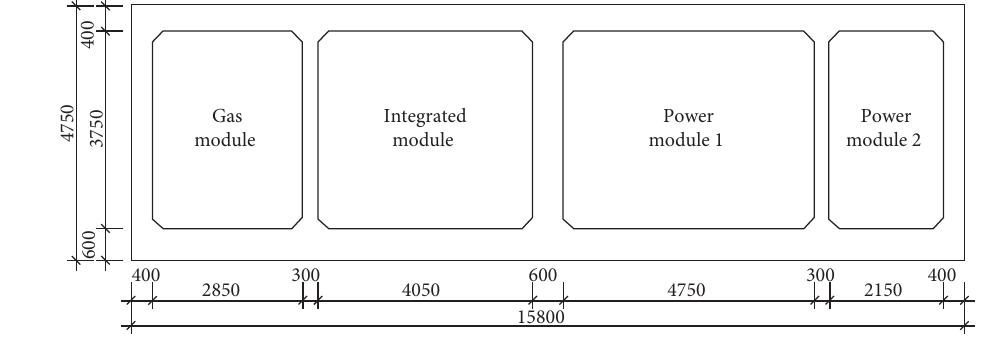
Figure 1: Schematic diagram of the utility tunnel (unit: